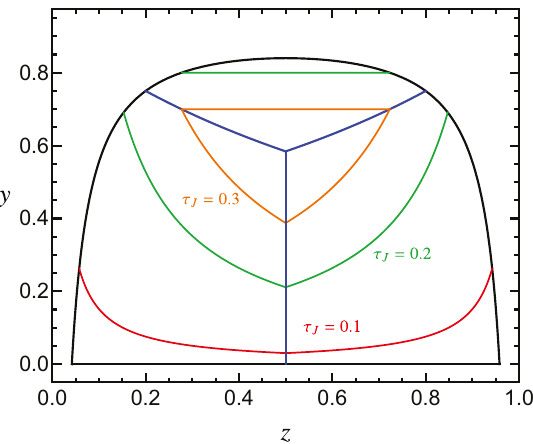
Figure 13 . Three-particle phase space (black lines), thrust boundaries (blue lines) and constant (cid:28) J value contour lines, with ^ m = 0 : 2.